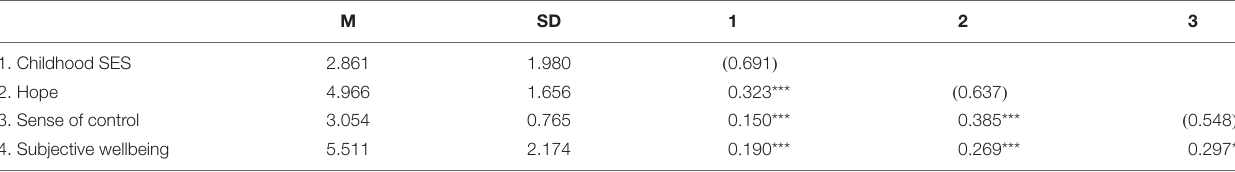
TABLE 2 | Descriptive statistics, Pearson’s correlations and the discriminatory validity.